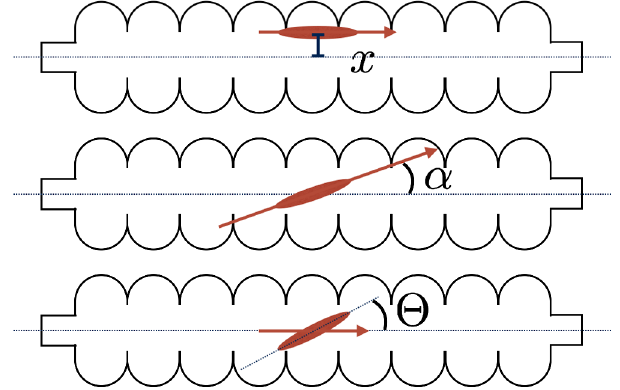
FIG. 1. Different scenarios for a bunch (red) traversing a cavity. In the top row, the paraxial trajectory has an offset x with respect to the cavity axis, and the middle row shows a trajectory tilt angle α . The bottom scenario illustrates a tilted bunch with angle Θ traversing the cavity on axis.